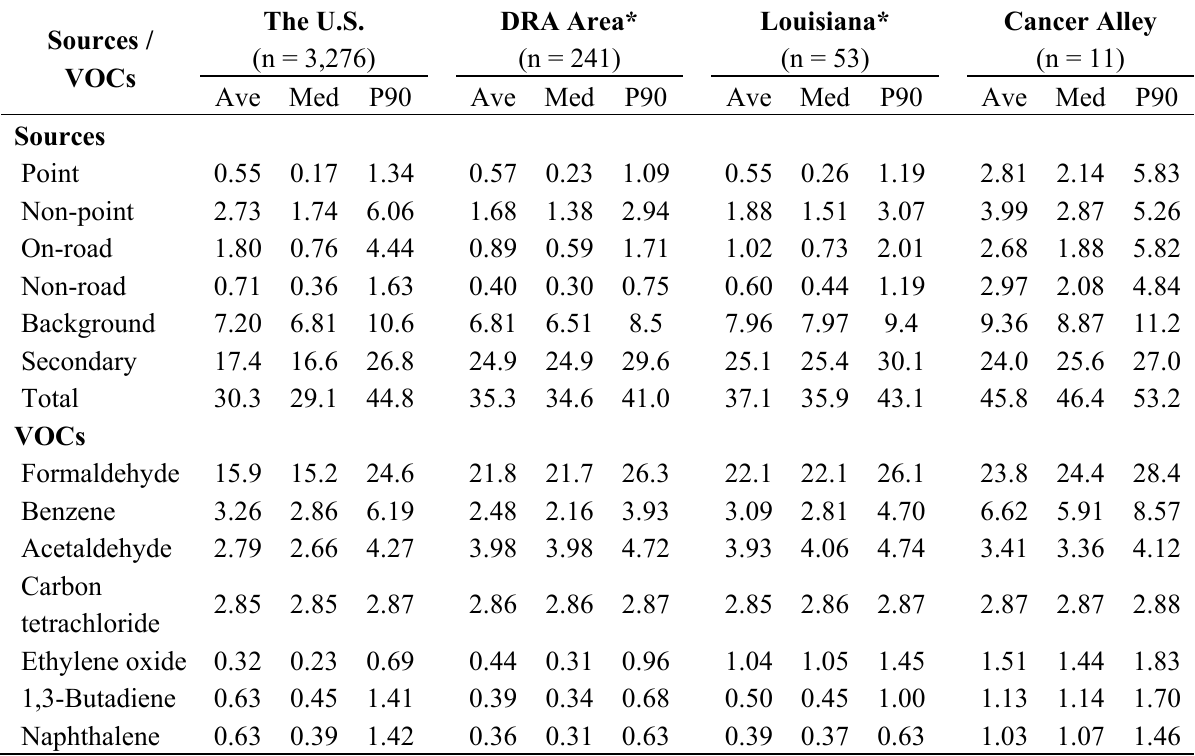
Table A4. Descriptive statistics of cancer risks (×10 − 6 , i.e. , 1 per million) contributed by different sources and the top 10 air toxics. DRA = Delta Region Authority. P90 = the 90th percentile. Individual compounds only included volatile organic compounds (VOCs).